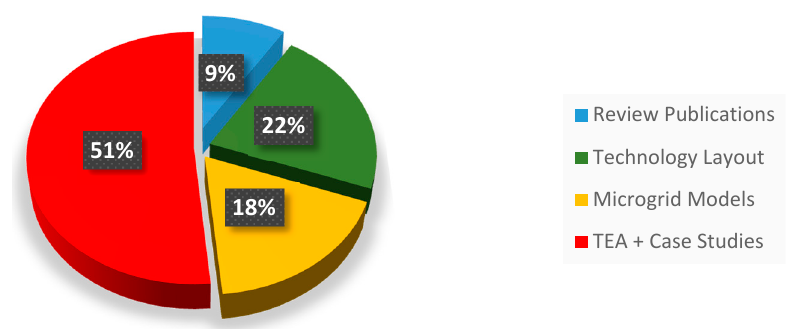
Figure 1. Distribution of microgrid research from a sample of 122 research articles.